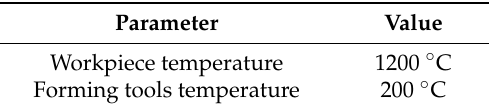
Figure 3. ( a ) Screw press, ( b ) forming tool system for die forging of bi-metal bevel gears. Table 3. Process parameters of the forging process.